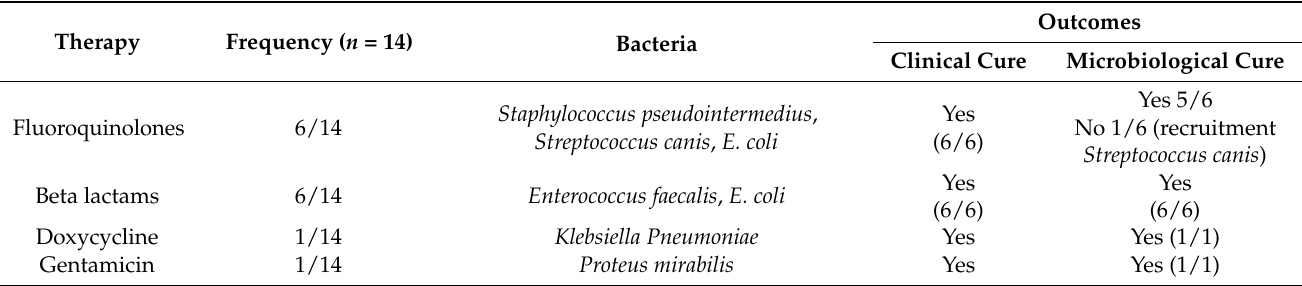
Table 3. Table summarizes drugs used to treat dogs according to results of susceptibility test, frequency of the different treatments considering total number of enrolled dogs (14), bacteria isolated in urine samples, clinical and the microbiological outcomes considering number of dogs that received that specific